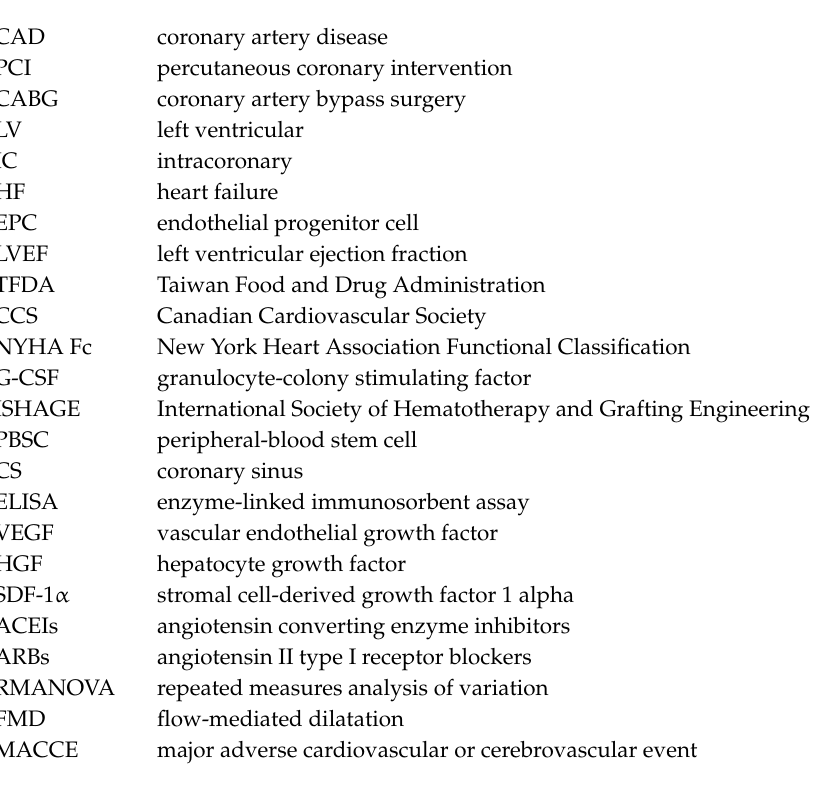
Supplementary Figure S1: Procedure for gating individual EPC surface makers; Supplementary Figure S2: Illustrating the presentation of the backing gate for EPC surface maker. Supplementary Table S1: Comparison of echocardiographic parameters between two groups at baseline and at 12